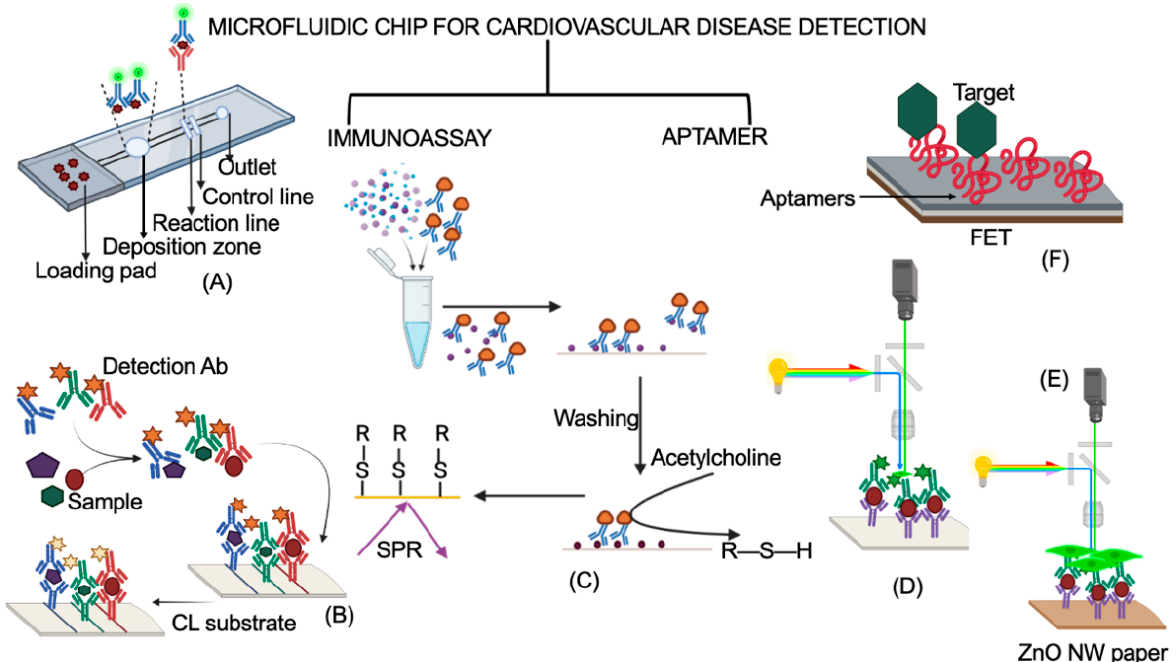
Figure 9. A schematic representation of two types of microfluidic chip biosensors for the detection of cardiovascular diseases. ( A – E ) are categorized as immunoassay ‐ based microfluidic chip biosensors, while ( F ) is a nucleic ‐ acid microfluidic chip biosensor. ( A ) LFIA ‐ mimicking silicon ‐ based microfluidic chip biosensor . Adapted from ref. [97]. ( B ) Miniaturized immunosensing microfluidic chip biosensor . Adapted from ref. [98]. ( C ) Snail ‐ shaped chemiluminescence based microfluidic chip biosensor . Adapted from ref. [99]. ( D ) Sandwich immunoassay ‐ based microfluidic chip biosensor . Adapted from ref. [100]. ( E ) Fluorogenic immunodevice . Adapted from ref. [101]. ( F ) Aptamer and FET ‐ array ‐ based microfluidic chip biosensor . Adapted from ref. [102]. The representation of the working principle in this figure is to explain the mechanism. The original research article